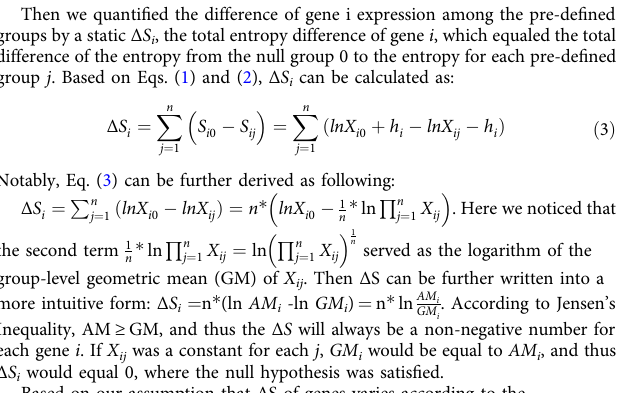
Table 5. Here we take training-test pair 1 (generated by GSE104276 24 and GSE108989 25 ) as an example. For dataset GSE104276, which comprised cells from human prefrontal cortex, we randomly sampled 70% of the cells as reference. Cells from GSE108989 (T cells) are not represented in the reference, and thus could be considered as negative cells. The remaining 30% cells of GSE104276 and cells from GSE108989 together formed the query dataset. For each training-test pair, we repeated the entire procedure including random sampling and classi fi cation for 50